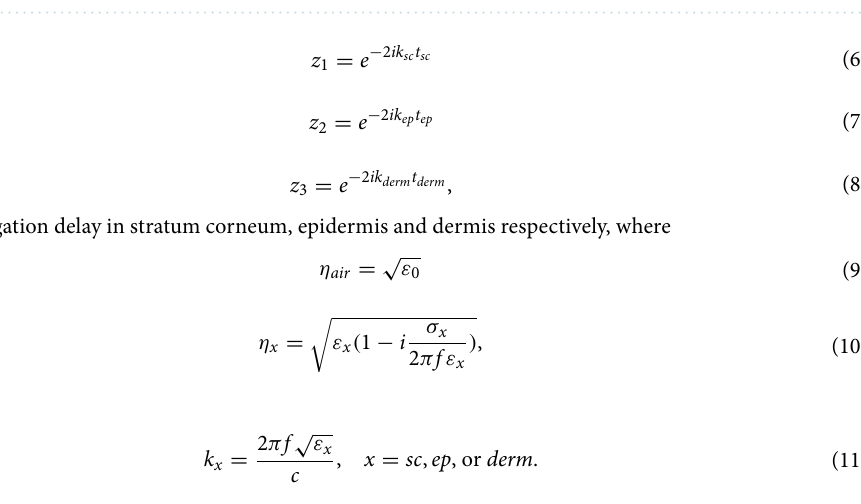
Figure 3. Spectrum from simulated data as function of sample rate and blood flow cycles. The first row ( a – c ) shows the spectra from sample rate (samples/s) at 100, 200 and 1000 with blood flow cycles fixed at 72 cycles per minute; the second row ( d – f ) the spectra at 50 cycles, 70 cycles, 90 cycles with a fix sample rate of